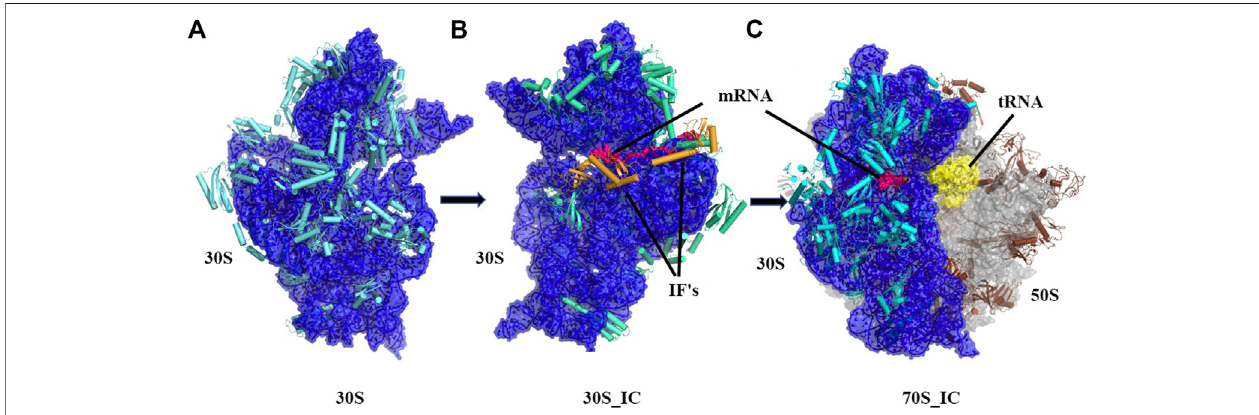
FIGURE 1 | Cartoon representation showing the pathway of assembly of 70S initiation complex from 30S ribosome. (A) Architectural view of 30S ribosomal complex which contains 16S rRNA (blue) and 20 small ribosomal unit proteins (orange) was obtained using structure PDB ID: 4JI1, (B) Frontal view of 30S initiation complex, where30S complexisbound tomRNA (dark blue) and twoinitiation factors, wasobtained usingPDB ID: 5LMN (C) 70Sinitiation complex,where 23.5S rRNA and 5S rRNA (light blue) along with 30 other proteins (grey) is shown bound to 30S complex and mRNA (dark